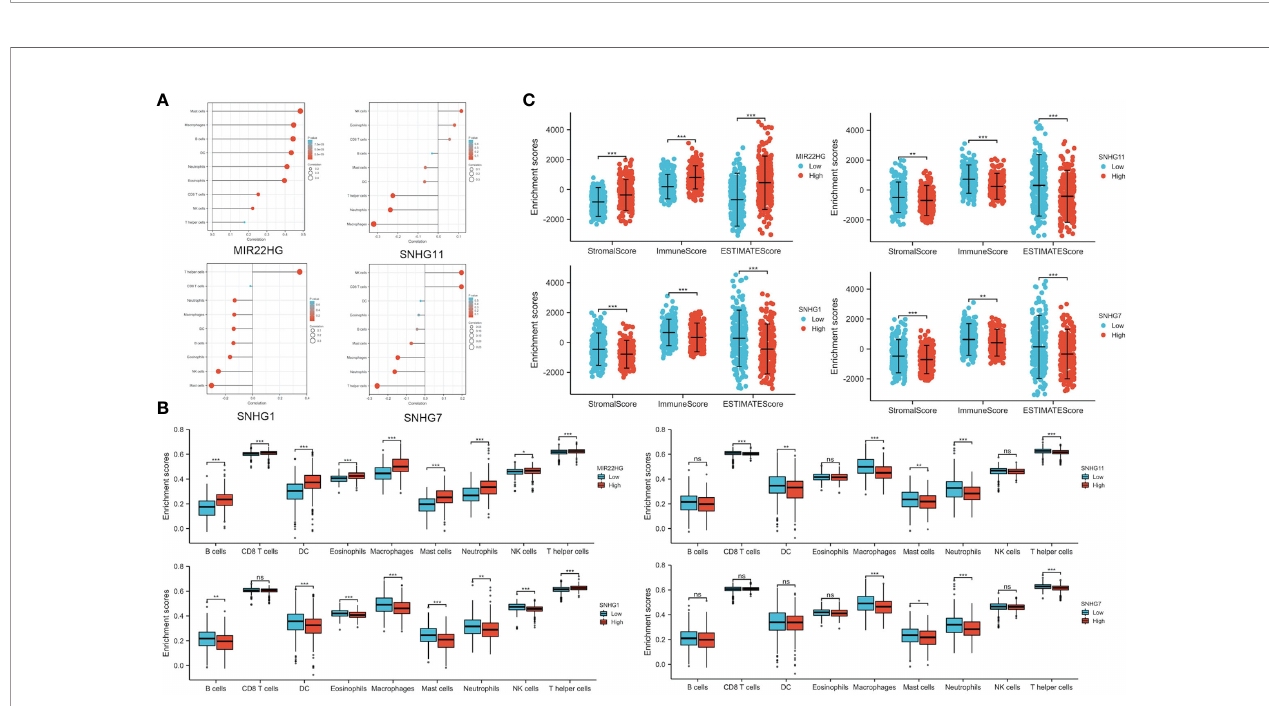
FIGURE 5 | Immune In fi ltration Analysis of Candidate PANoptosis- and Metastasis-Related lncRNAs. (A) Correlation of candidate lncRNAs with different tumor- in fi ltrating immune cells. (B) Immune cell in fi ltration in high and low lncRNA expression groups. (C) Comparison of ESTIMATE, immune, and stromal scores in candidate lncRNA high and low expression groups. * P < 0.05; ** P < 0.01; *** P < 0.001; ns P > 0.05 (ns, not signi fi